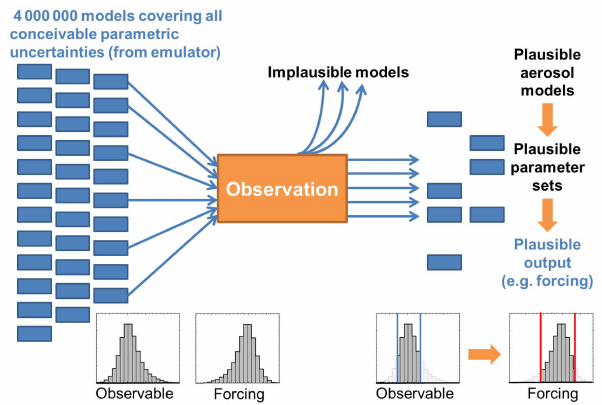
Figure 1. Schematic of the methodology for observational con- straint of parametric model